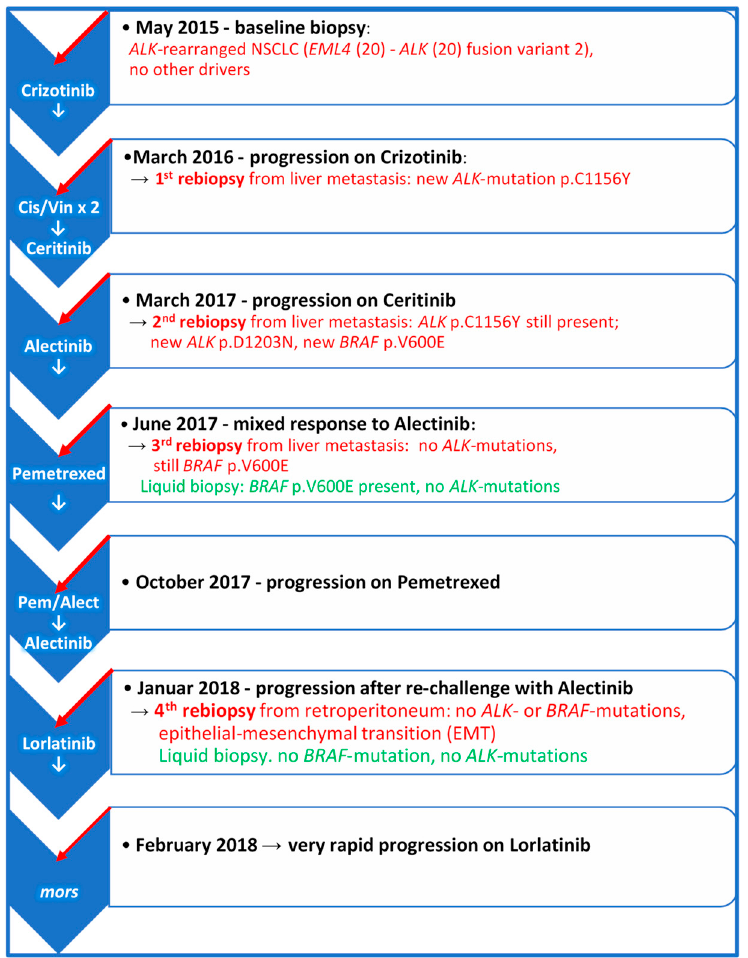
Figure 4. The course of the disease and systemic therapy from baseline at diagnosis to final progression. The scheme illustrates the molecular findings in the rebiopsies taken from new emerging metastatic sites and plasma at the time of progression on the indicated treatments. Cis/Vin × 2 = Two cycles of Cisplatin/Vinorelbine.